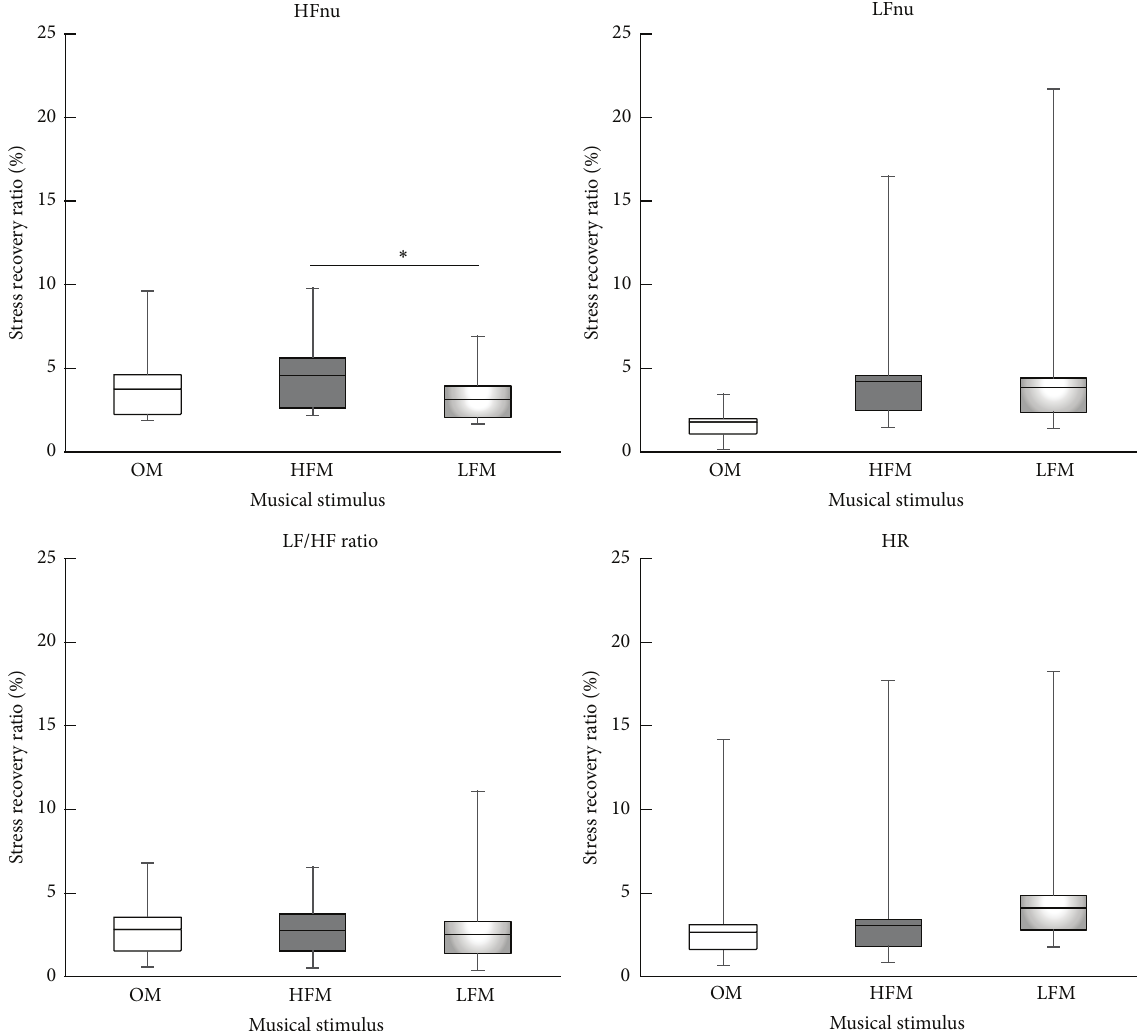
Figure 2: Stress recovery ratio of heart rate variability index. Box plot showing median (central lines) and 25% and 75% quartile ranges around the median (box width) and upper and lower limits. Error bars indicate standard deviation. ∗ 𝑝 < 0.05 ; HFM: music with an amplified high-frequency component; HFnu: high-frequency normalized unit; HR: heart rate; LF/HF: low-/high-frequency ratio; LFM: music with an amplified low-frequency component; LFnu: low-frequency normalized unit; OM: original